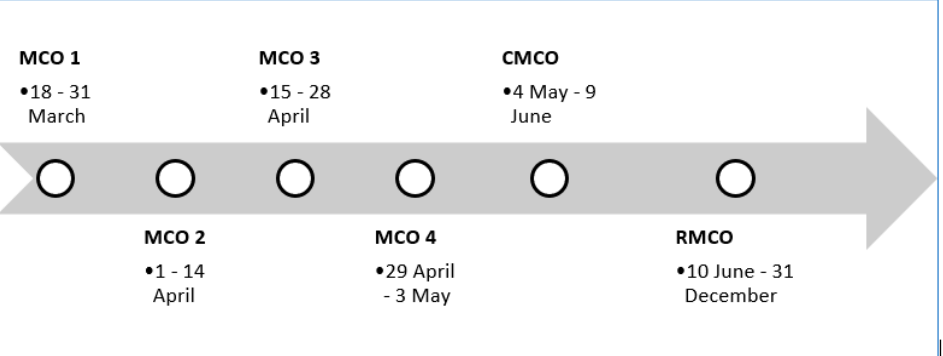
Figure 1. Six MCO phases in Malaysia. MCO: movement control order, CMCO: conditional movement control order, RMCO: recovery movement control order. Source: [1,3,4,6].